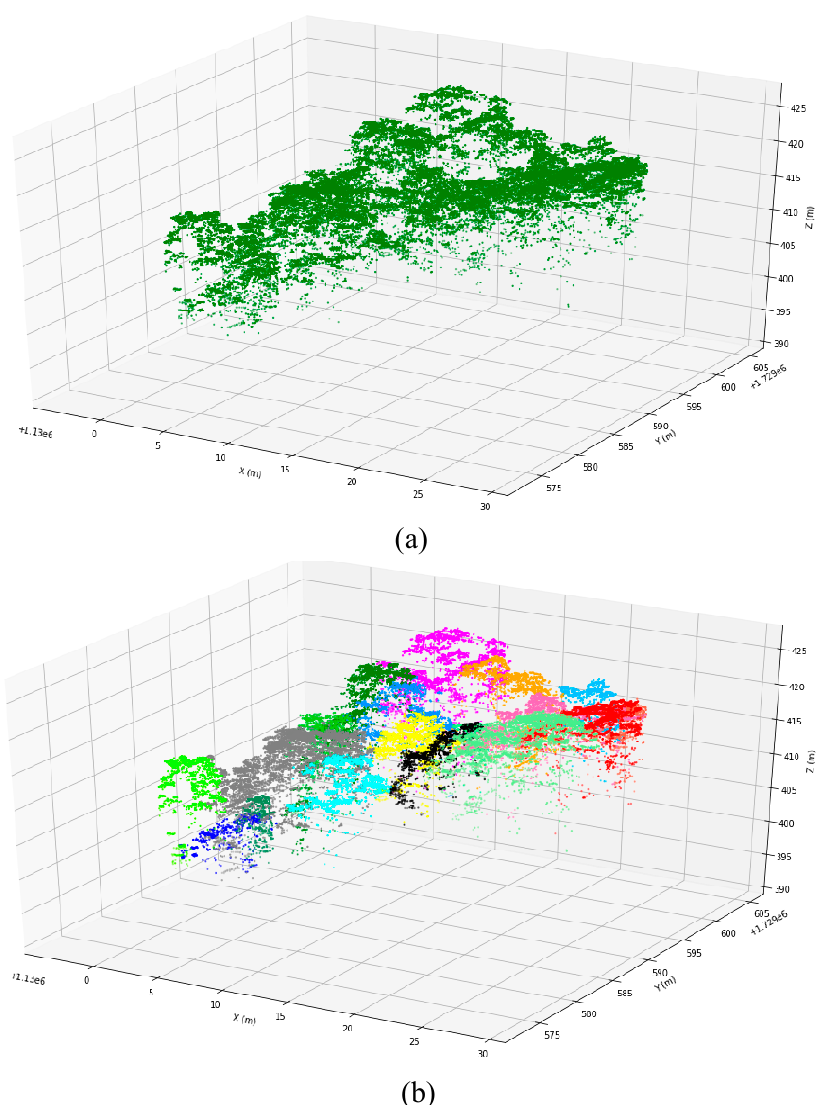
Figure 10. ( a ) original airborne LiDAR point cloud and ( b ) segmented point cloud. The color of points indicates individual tree segments.